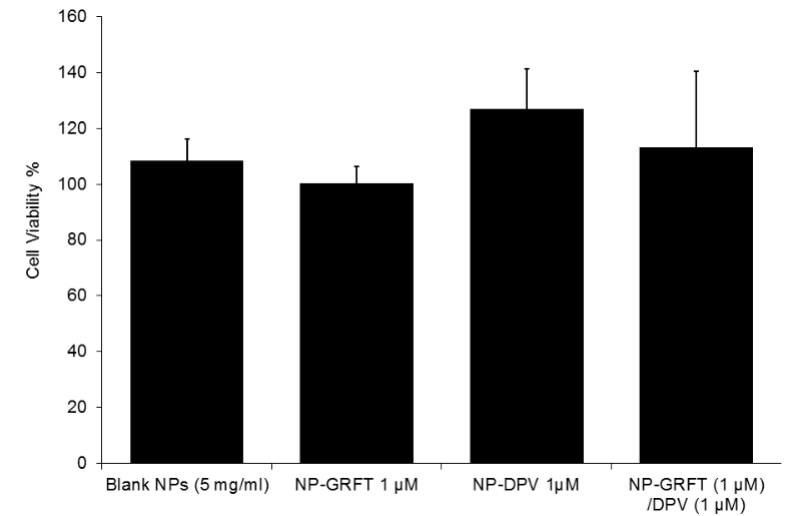
Figure 10. Toxicity of GRFT and DPV loaded PLGA nanoparticles. Viability of TZM-bl cells was measured by the CellTiter-Glo ® (Promega, Madison, WI, USA) viability assay kit demonstrating non-toxic nature ( ≥ 80% viability) of NP-GRFT, NP-DPV, and NP-GRFT / DPV. Vehicle control (blank nanoparticles) at the concentrations tested showed no reduction of viability (108% ± 7%), indicating non-cytotoxicity of PLGA polymer itself. Negative control = media only. Vehicle control for all nanoparticles was evaluated at 5.0 mg of polymer/mL.